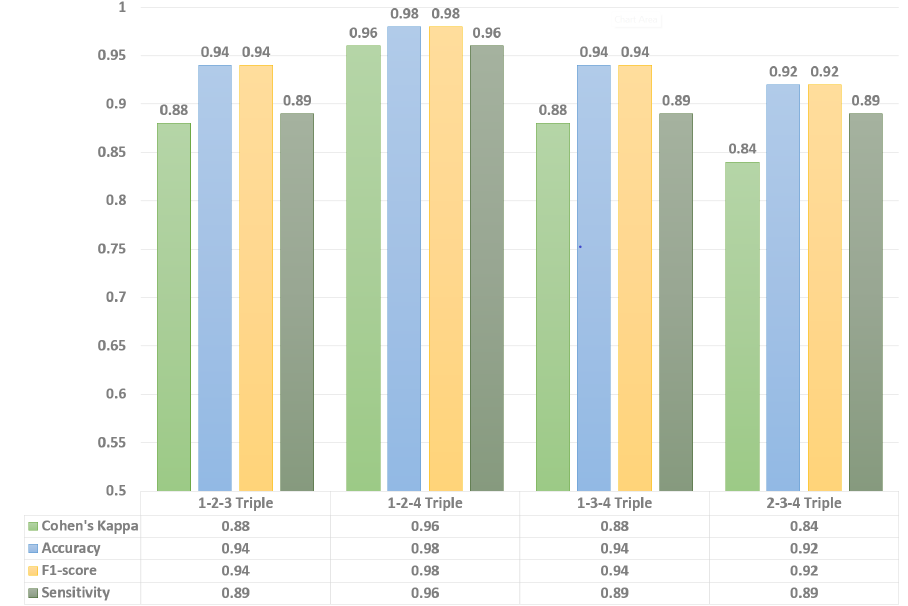
Figure 10. Comparison of performance in 3-bioradar system configurations.